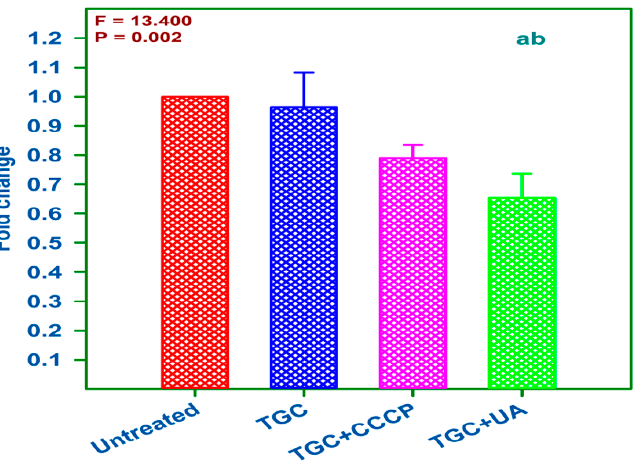
Figure 4. Efflux pump inhibition activity determined by qRT-PCR for AI 7574. Values are presented as means ± SEM (n = 3 each, triplicate data of each group). Untreated: AI 7574 isolate alone; TGC = tigecycline alone; TGC + CCCP = tigecycline + carbonyl cyanide m-chlorophenylhydrazone; TGC + (+)UA = tigecycline + (+)Usnic acid. Compared with the standard, a statistical reduction in expres- sion levels with TGC + (+)UA was seen. P is the statistically significant difference in the mean val- ues among the groups. F is the cumulative probability distribution among the groups . a: Signifi- cantly different from the untreated group. b: Significantly different from the TGC group.